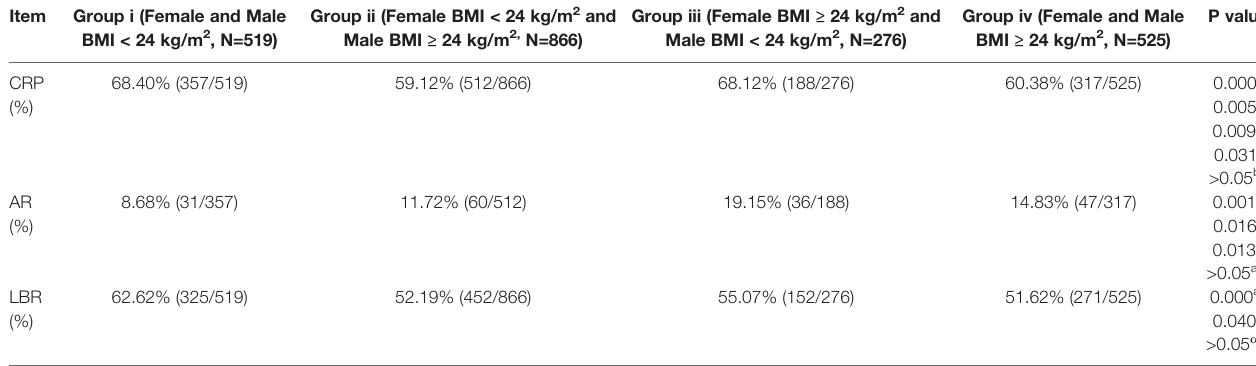
TABLE 3B | Effect of female and Male BMI on pregnancy outcome in ICSI cycles. Item